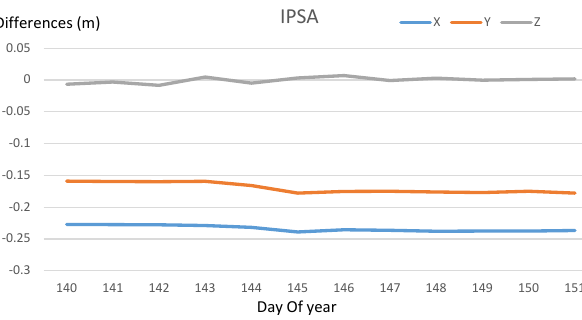
Figure 12. IPSA station coordinate